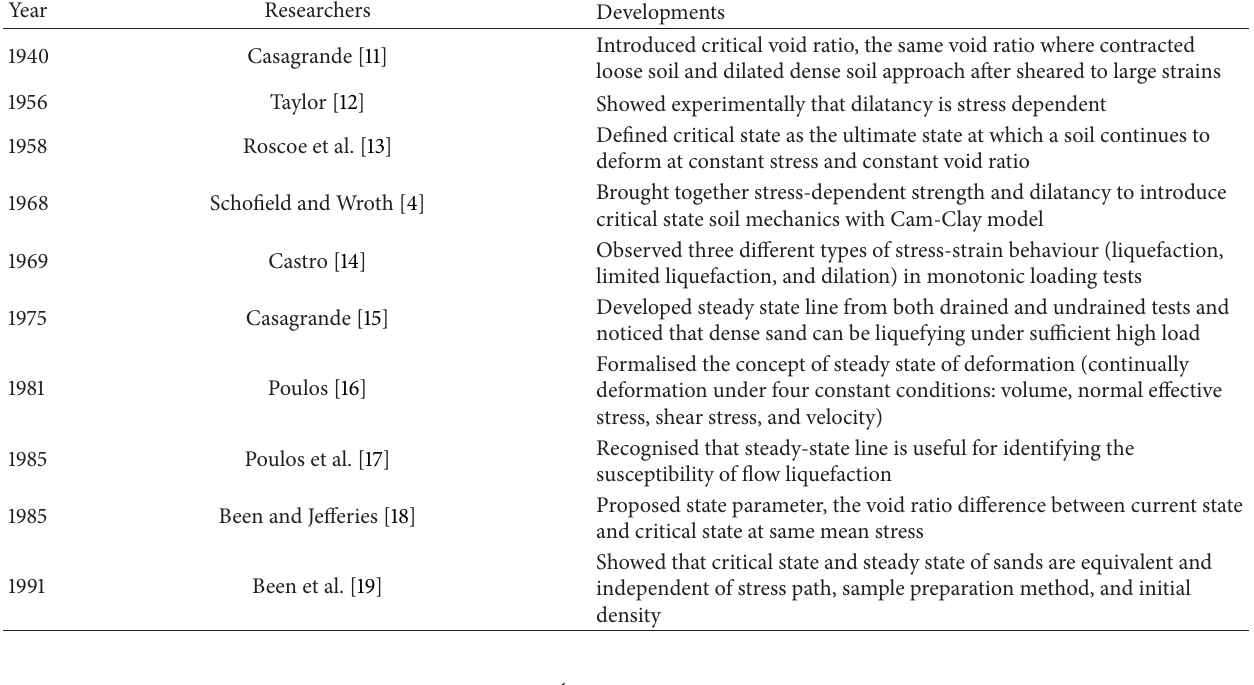
Table 1: Overall developments of CSSM with respect to soil liquefaction.